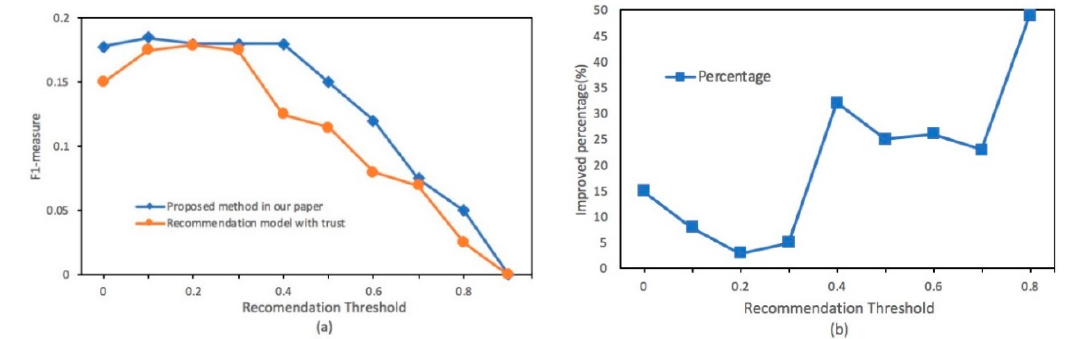
Figure 6. The result of the experiment in the health and personal care shop. ( a ) The results of F 1-measure under different recommendation thresholds; ( b ) the percentage of improvement of F 1-measure under different recommendation thresholds.